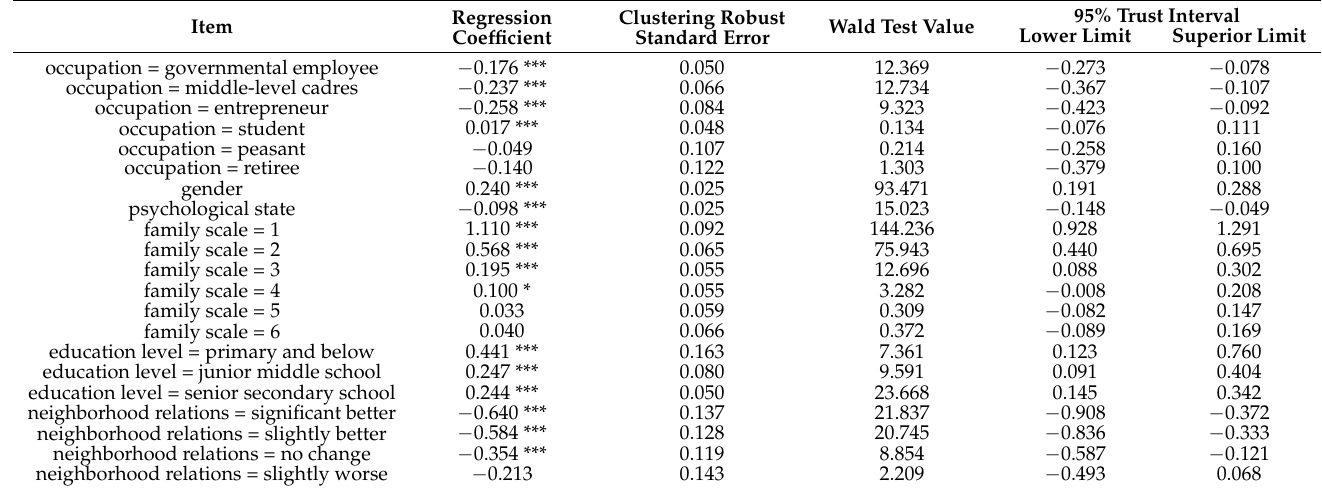
Table 4. Simulation results of interaction among family